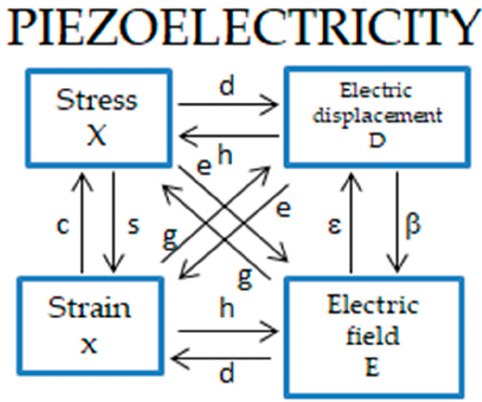
Figure 7. Definition of the piezoelectric coefficients (adapted from [91]).